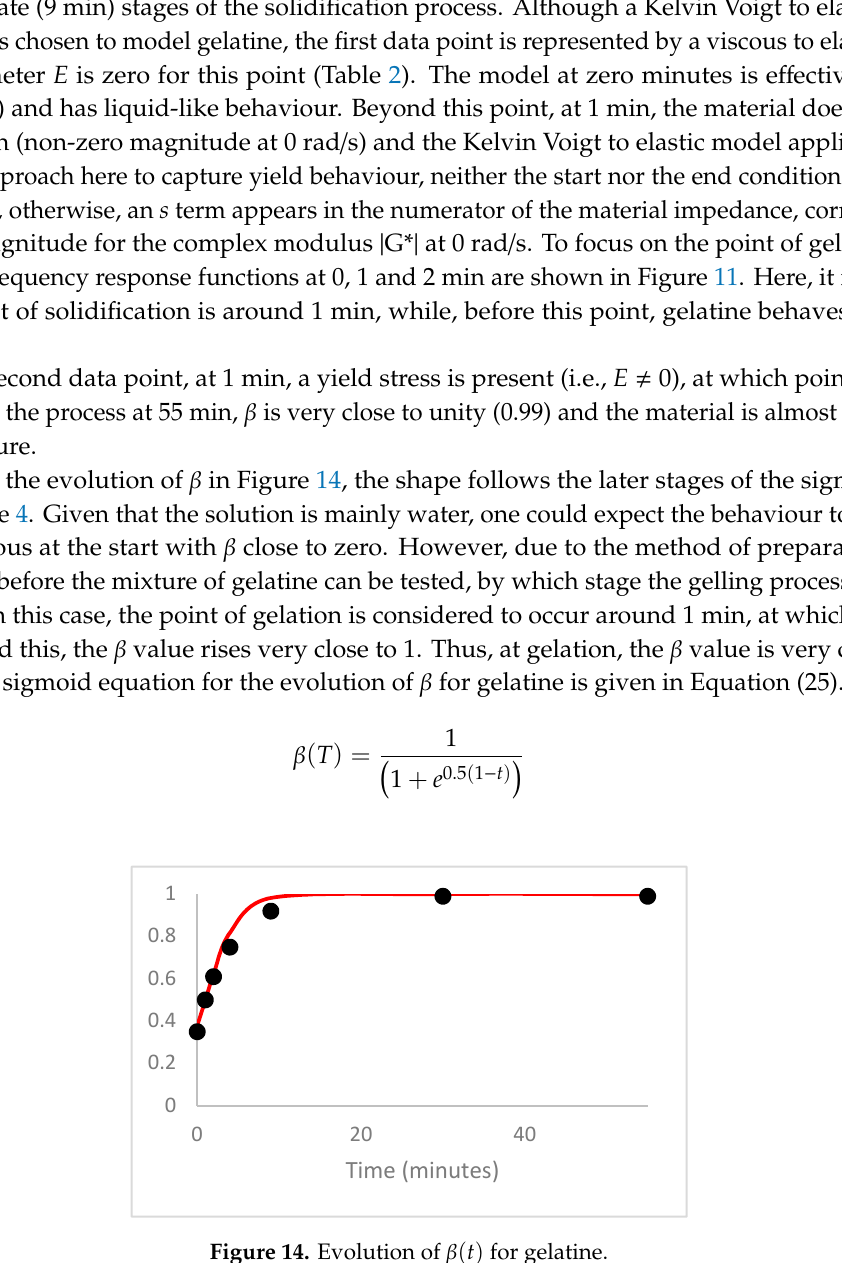
Figure 14. Evolution of 𝛽(𝑡) for gelatine